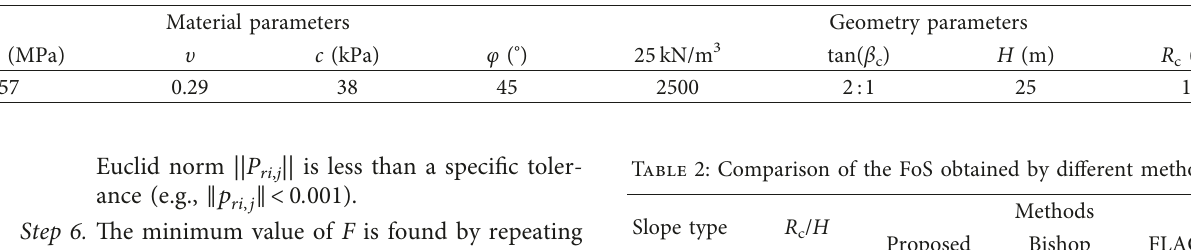
Table 1: Geometry and material parameters of the concave slope [19].